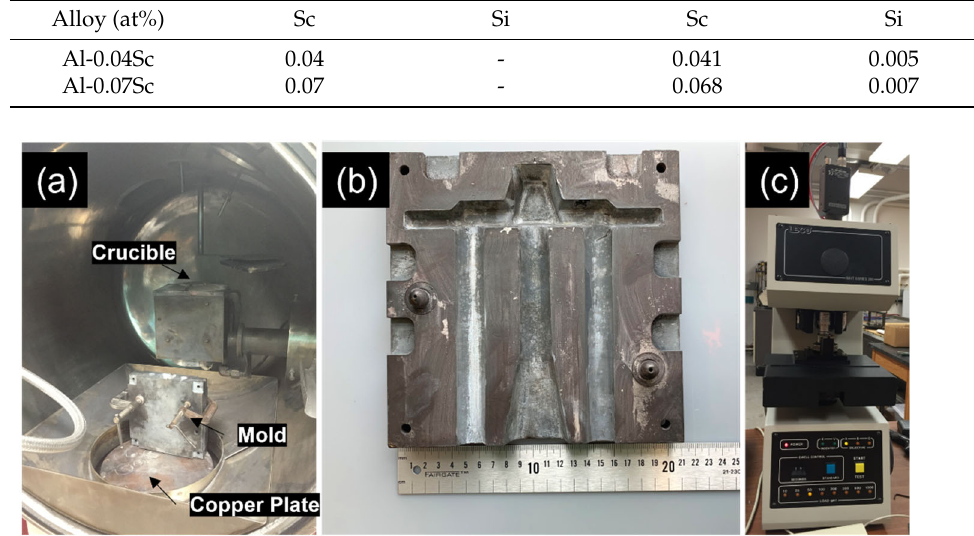
Figure 2. ( a , b ) The samples for experimental verification were cast into a permanent mold using a vacuum induction melter (VIM). ( c ) Hardness of the experimental samples was measured using a Leco Vickers hardness tester. Table 1. Expected and observed alloy compositions. Target Composition